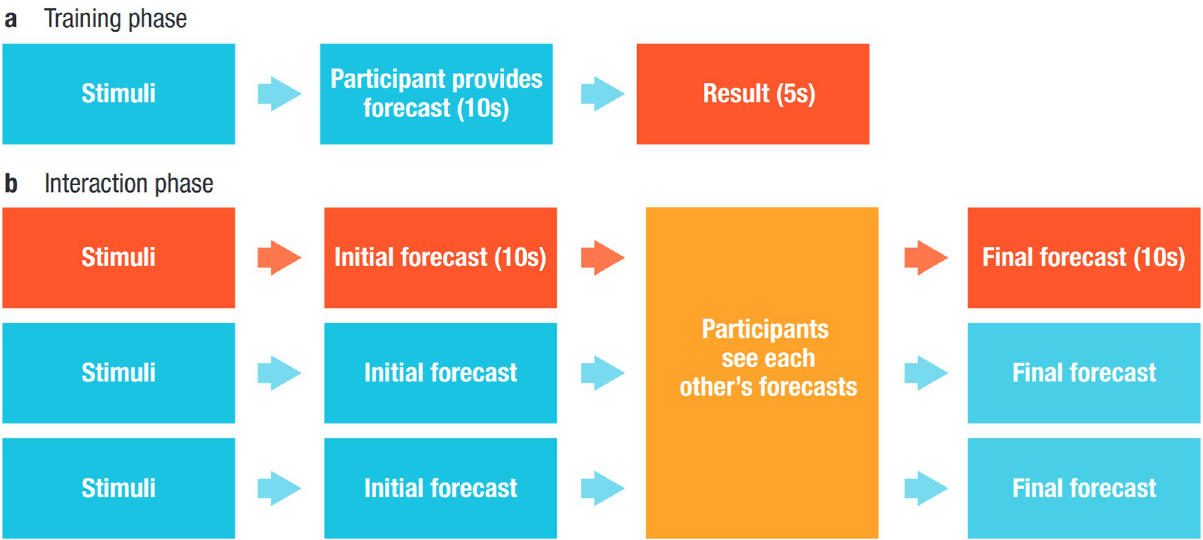
Fig 1. Experiment timeline. (a) During the first 110 rounds, participants see measurements from their indicator group and need to provide weather forecasts. On each round they receive feedback (“It rained” vs . “It did not rain”), thus allowing them to learn the predictive relation between the indicator and the outcome. (b) During the interaction phase, after seeing their indicator measurements and providing their independent answer, participants could see the forecasts made by other participants, before receiving round